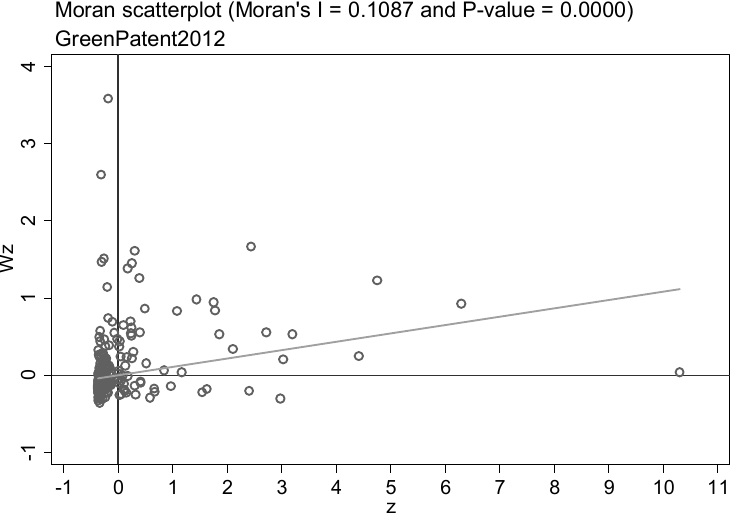
Figure 2. Scatter plots of the local Moran’s index of green patents in China’s cities in 2007.